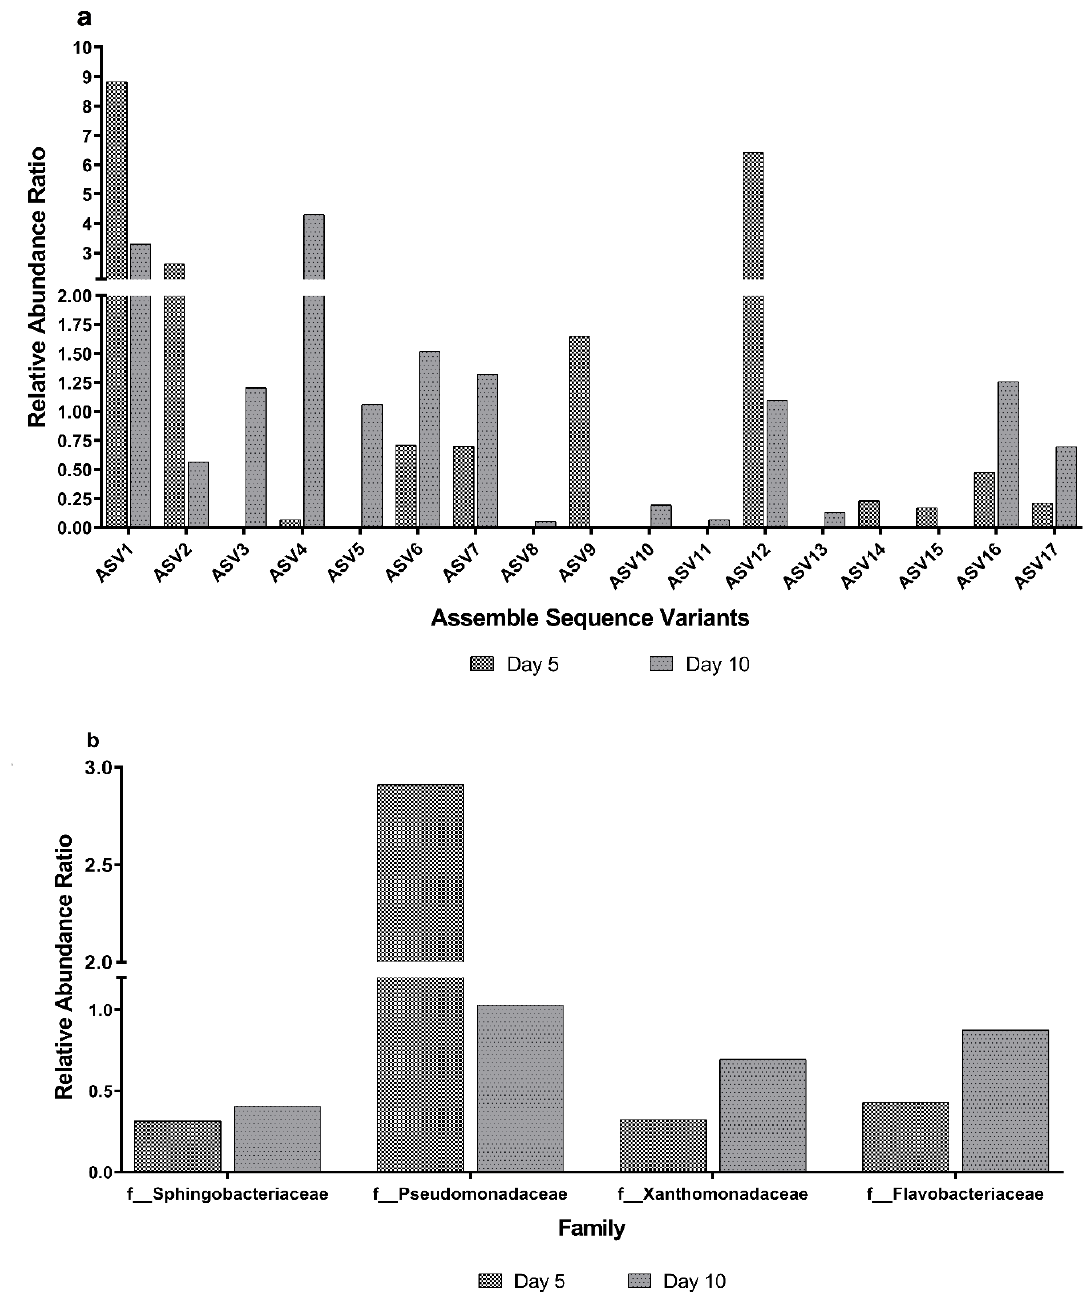
Figure 3. The relative abundance (RA) ratio of ( a ) ASVs (17 ASVs with taxa identification in Table 4) and ( b ) taxa rank family (4) identified as significantly different in abundance on sampling days 5 and 10 by ANCOM analysis at a false discovery rate (FDR) of 0.05. The RA ratio is calculated as RA on day 5 or day 10 divided by RA on day 0. f-family.